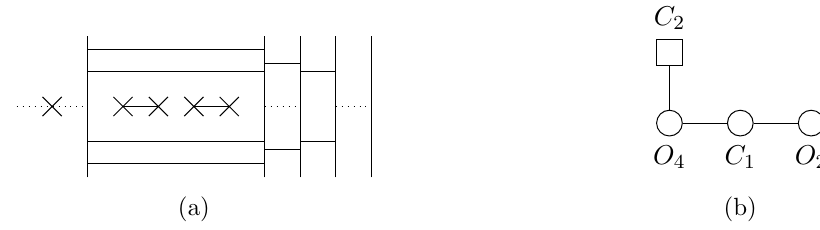
Figure 13. Example of a brane con(cid:12)guration and its corresponding quiver. In (a) the horizon- tal direction corresponds to space direction x 6 , the vertical direction corresponds to space direc- tions ~x = ( x 3 ; x 4 ; x 5 ) and the direction perpendicular to the paper corresponds to space directions ~y = ( x 7 ; x 8 ; x 9 ). Vertical solid lines represent half NS5-branes, crosses represent half D5-branes, horizontal lines in the center of the diagram represent O3-planes: a solid line represents an g O 3 (cid:0) , the dotted line to the left of the leftmost half D5-brane represents an g O 3 + , the other dotted lines all represent O 3 + s. O 3 (cid:0) s are located in the spaces between half (cid:12)vebranes that have been left empty. (b) is the corresponding quiver, where the groups are in agreement with table 2; the gauge node C 0 has been